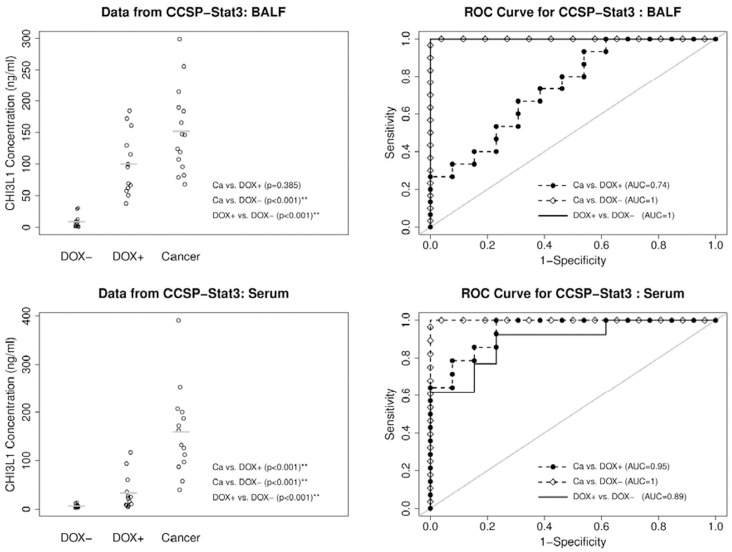
ELISA analyses of CHI3L1 protein in BALF and serum of CCSP-rtTA/(TetO)7-CMV-Stat3C bitransgenic mice.Left: CHI3L1 protein concentrations in BALF and serum of doxycycline-treated and untreated bitransgenic mice. Right: ROC (Receiver Operating Characteristic) curve analyses to determine the area under the curve (AUC). Dox-: doxycycline-untreated mice; Dox+: doxycycline-treated mice without showing lung tumor; Cancer, doxycycline-treated mice with lung tumor. Mean ± SD in BALF (n>13), DOX -: 8.8±10.0, DOX +: 100.0±49.0, Cancer: 151.8±67.3. Mean ± SD in serum (n>13), DOX -: 6.2±3.7, DOX +: 33.5±35.6, Cancer: 159.0±90.0. The gray lines represent the mean values.